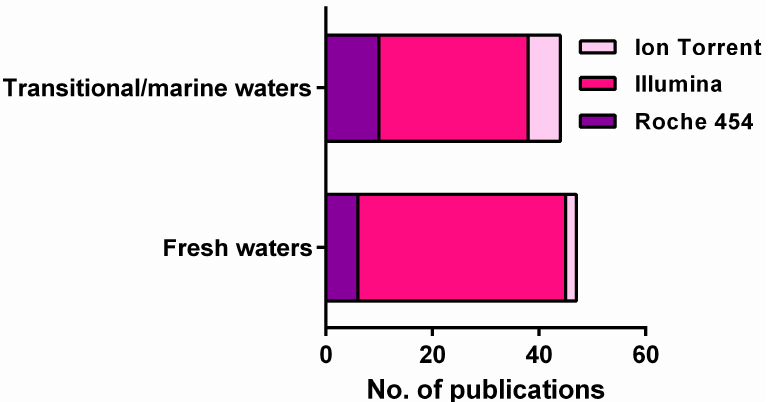
Figure 6. Sequencing platforms used for assessing macroinvertebrate diversity through metabarcod- ing in fresh and transitional/marine waters.